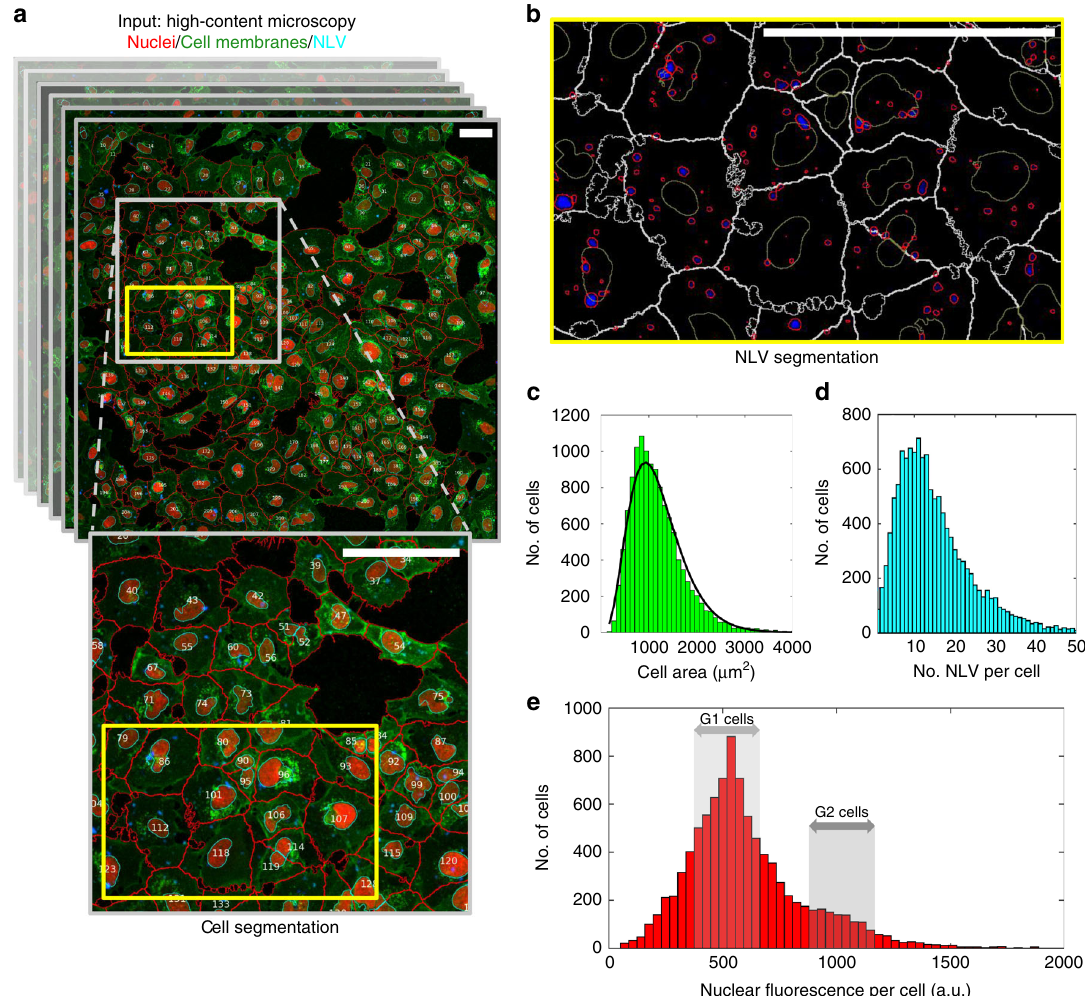
Fig. 1 Image-based analysis of nanoparticle delivery to adherent cells. a A typical fi eld-of-view (taken from >100 per experiment) imaged by laser scanning confocal microscopy of lung adenocarcinoma A549 cells exposed to a 2.0-nM dose of Qtracker ® 705 quantum dot nanoparticles for 1 h. Cell identi fi cation numbers alongside nuclear and cell membrane segmentation masks achieved by image analysis (see Methods) are shown as blue and red lines, respectively. b For each cell (segmentation outlines shown), individual nanoparticle-loaded vesicles (NLVs) were also segmented (red outlines). c – e In this way, image analysis allowed nuclear, cell and NLV features (e.g., size, shape and fl uorescence intensity) to be measured for ~10 4 cells and ~10 5 NLVs for each exposure condition (i.e., dose – time combination). This allowed factors such as area ( c ), number of NLVs ( d ) and the DNA content ( e ) of each cell to be measured, and allowed probabilistic models to be constructed for statistically defensible cell populations (e.g., a gamma function to describe cell area distributions, black line in c ). (Scale bars = 100 μ m.) The underlying data are provided in the BioStudies database under the accession